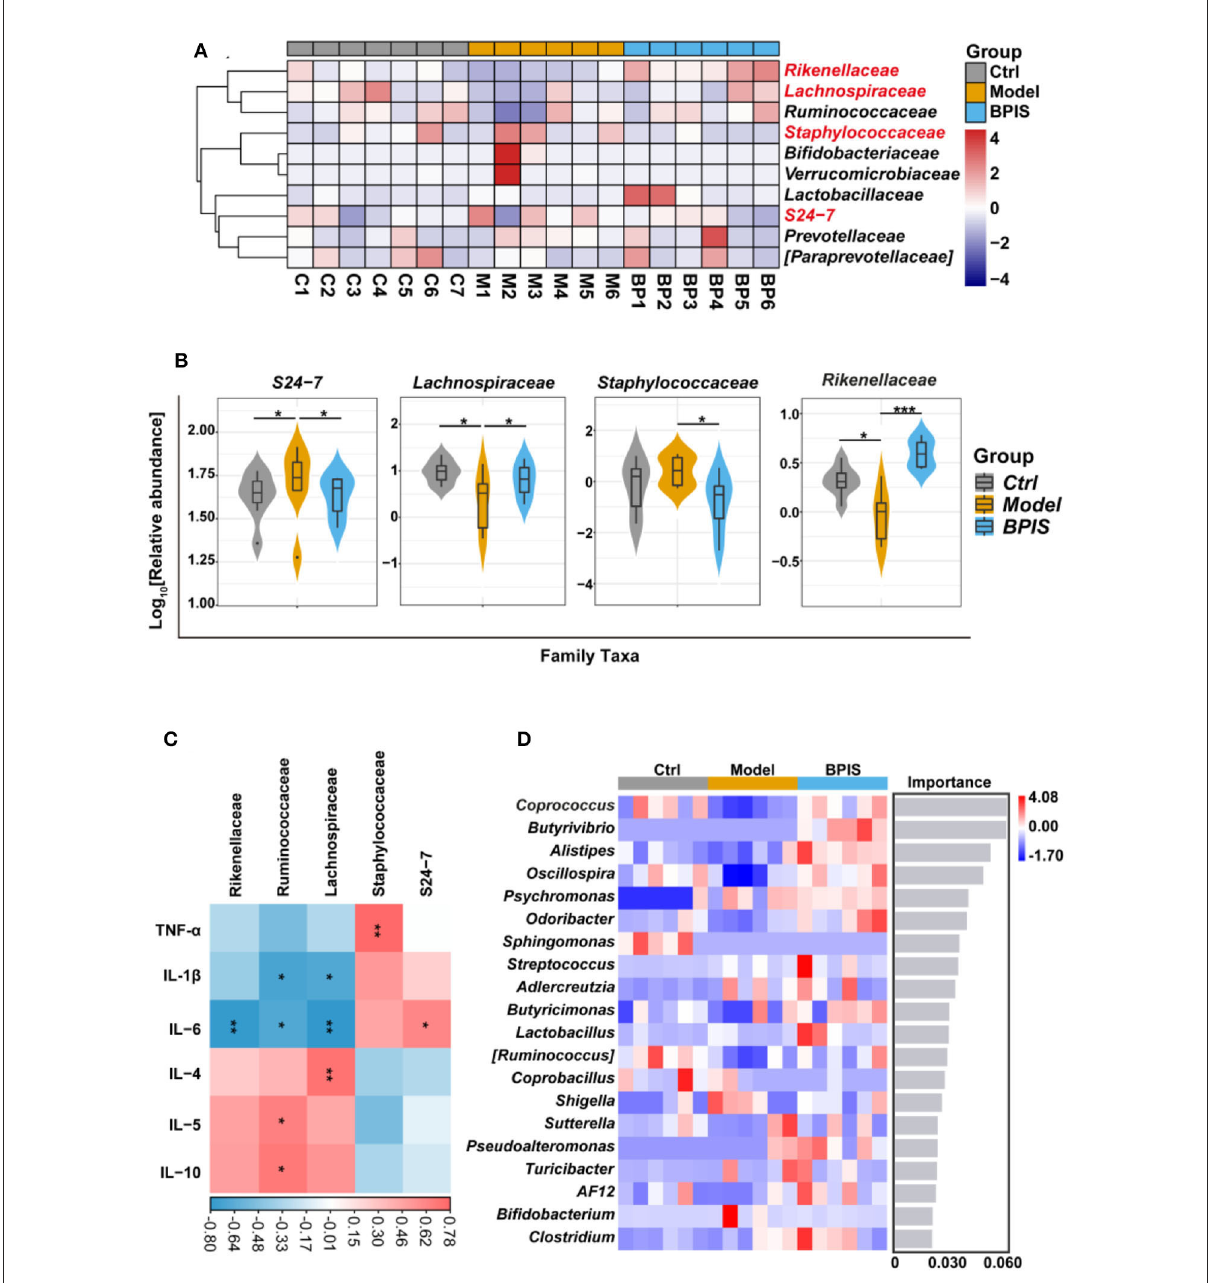
FIGURE6 BPIS regulated the growth of certain commensal bacteria at the family level. (A) Heatmap showing the relative abundance of families, ranking the top 10 from each sample. (B) Taxonomic composition indices on a log 10 scale for significantly different families of fecal bacteria from differential groups. (C) Correlation analysis between different families and inflammatory cytokines in DSS-induced colitis mice. (D) At the genus level, random forest analysis and cross-validations were performed on the absolute abundance of microbial species in each group of samples. Data are presented as the means ± SD ( n ≥ 5) and were analyzed by an ordinary one-way ANOVA with Tukey’s multiple comparisons. * p < 0.05, ** p < 0.01, *** p < 0.001.